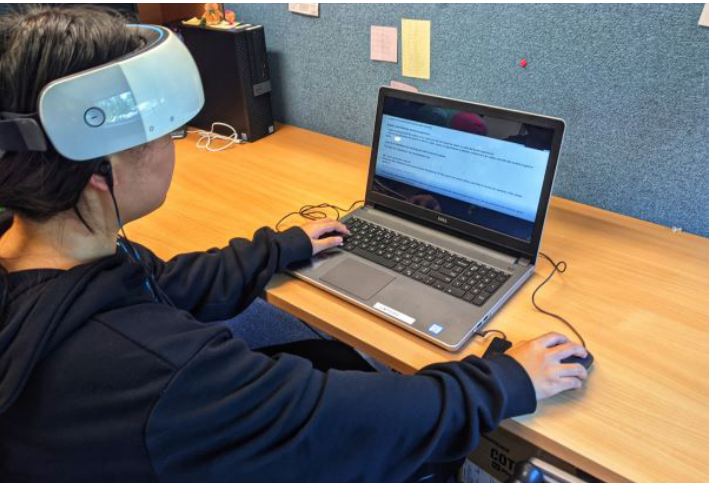
Figure 3. Experimental